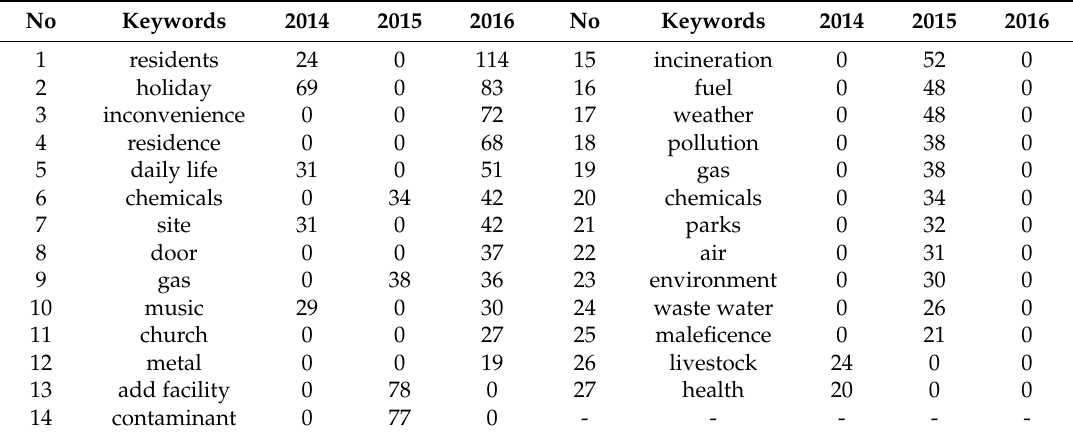
Table 5. The frequency of all the words except for the words that have appeared for three